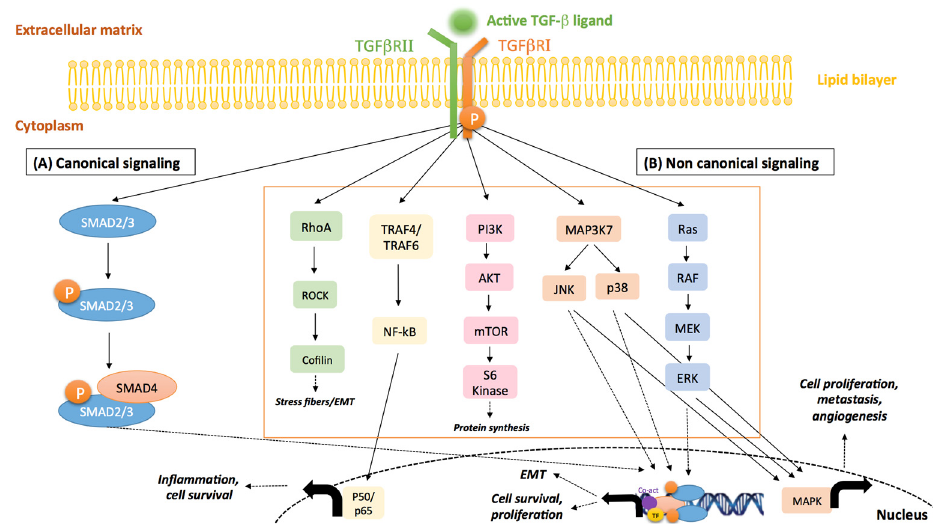
Figure 1. Canonical and non-canonical TGF- β signaling pathways. ( A ) In the canonical signaling pathway, biologically active TGF- β ligands bind to TGF β RII, which in turn activates TGF β RI. TGF β RI-regulated SMAD2/3 proteins are phosphorylated at their C-terminal serine residues and form complexes with SMAD4 (co-SMAD), initiating a number of biological processes through transcriptional regulation of target genes. ( B ) In the non-canonical signaling pathways, the TGF- β receptor complex transmits its signal through other factors, such as the mitogen-activated protein kinases (MAPKs), phosphatidylinositide 3-kinase (PI3K), TNF receptor-associated factor 4/6 (TRAF4/6) and Rho family of small GTPases. Activated MAPKs can exert transcriptional regulation either through direct interaction with the nuclear SMAD protein complex or via other downstream proteins. Moreover, activated JNK/p38/ERK act in concert with SMADs to regulate cellular apoptosis and proliferation, whereas they mediate metastasis, angiogenesis and cellular growth through other transcription factors, such as c-JUN and ATF. RhoA/ROCK can be activated by TGF- β to induce actin stress fiber formation during EMT via a non-transcriptional mechanism. TGF- β can activate PI3K and AKT by inducing a physical interaction between the PI3K p85 subunit and the receptor complex leading to translational responses via mTOR/S6kinase activation. TGF- β activation of the TRAF proteins can initiate nuclear factor- κ B (NF- κ B) signaling activity, leading to the inflammatory response among other processes. The arrows indicate activation/signaling direction of the respective pathway.